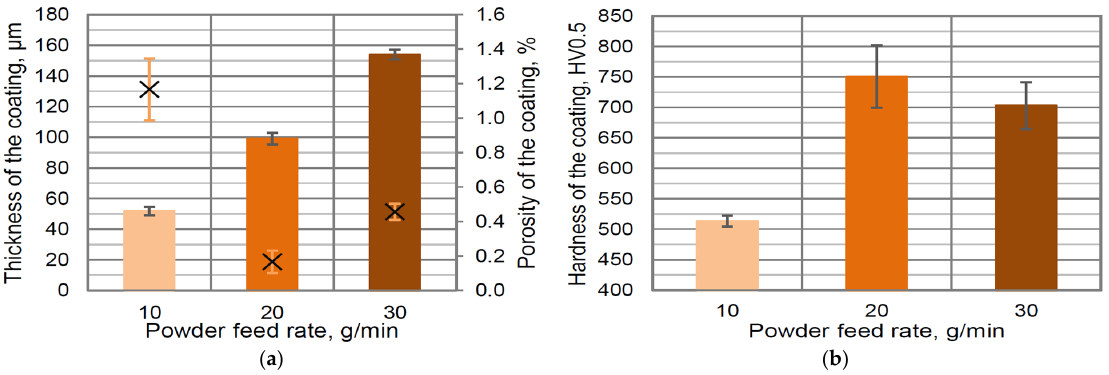
Figure 5. The influence of power feed rate on thickness/porosity (in the figure, the mean value of the porosity is marked as ×) ( a ) and hardness ( b ) of developed coating containing 10 wt. % YSZ additions.